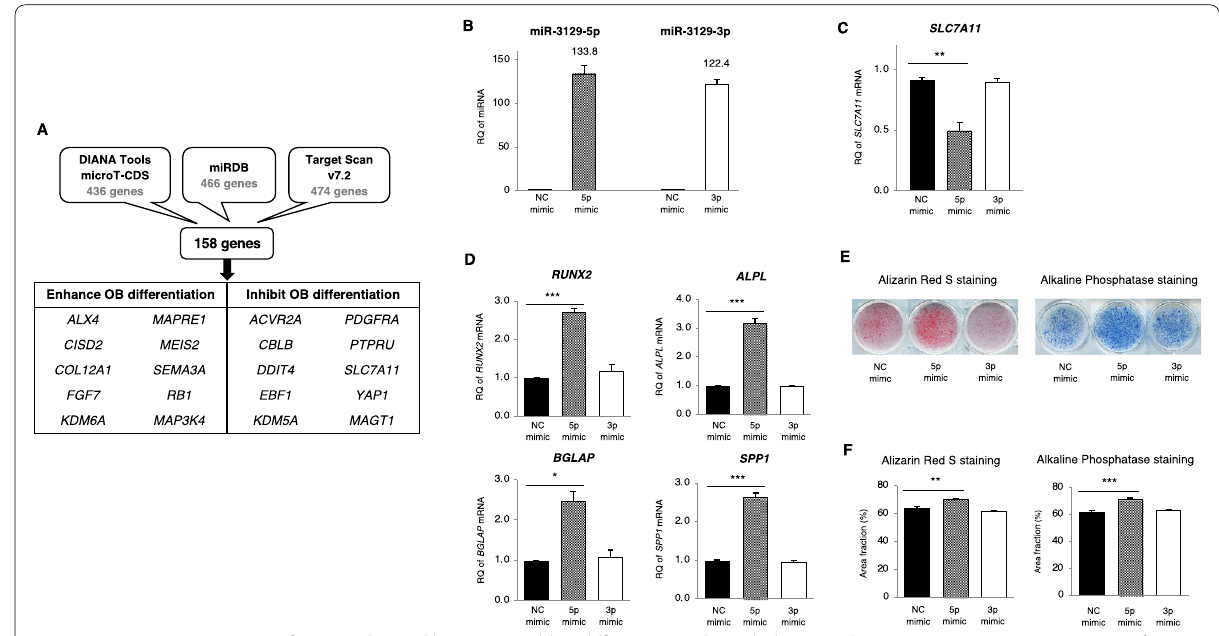
Fig. 5 miR‑3129‑5p mimic transfection enhanced hBMSC osteoblast differentiation through downregulating SLC7A11 . A Massive screening for miR‑3129‑5p putative target genes using three different databases. B – D Expression of miR‑3129 ( B ), SLC7A11 ( C ), and osteoblast markers ( D ) in MSCs at 48h ( B , C ) and day 18 ( D ) after transfection with miR‑3129‑5p and miR‑3129‑3p mimics. The levels of miRNA and mRNA expression were quantified by qPCR. The amounts of miRNA and mRNA transcripts were expressed relative to the amounts of U6sn and GAPDH transcripts, respectively. E , F Alizarin Red S and alkaline phosphatase staining were performed in three independent experiments at day 21 after transfection of miR‑3129 mimics ( E ), followed by quantification with ImageJ software ( F ). Data are expressed as mean SD from three independent experiments ± (each n 3 in B , C , D , E , and F ). * p < 0.05, ** p 0.001, *** p < 0.001 vs. NC mimic by Student’s t ‑test. NC, negative control; OB, osteoblast; RQ, relative = =